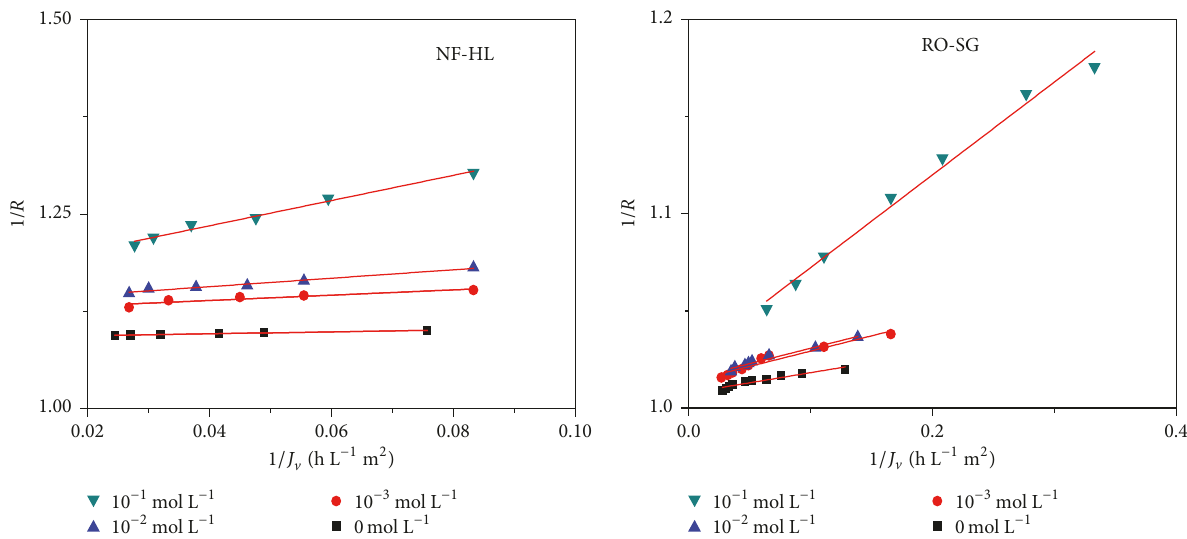
Figure 6: Variation of 1/R in function of 1/𝐽 V for different KCl concentrations ( 𝐶 Cr ( VI ) = 50 mg L −1 , 𝑌 = 50%, pH = 8, and 𝜃 = 25 ∘ C).